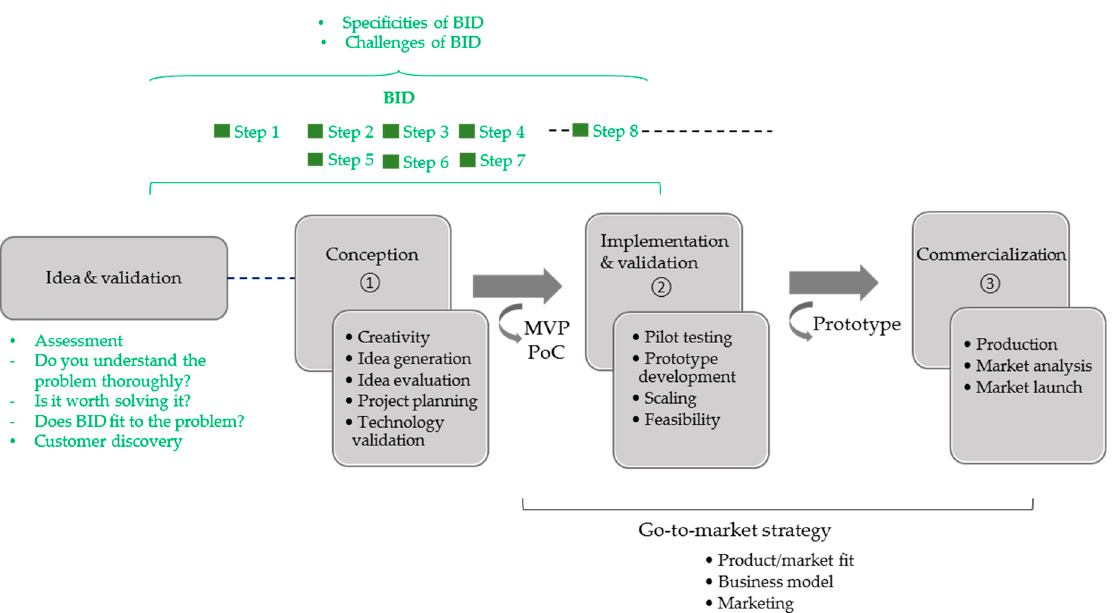
Figure 1. Phases of the innovation process linked to the eight steps of the biologically inspired design (BID) process as described with the unified problem-driven approach of biomimetics by Fayemi et al. [11]. ① , ② , and ③ indicate the main phases of a simplified innovation process. The eight steps of BID include specific tasks which must be performed and are linked to commonly known challenges [24,30–32] which must be overcome. BID: Biologically inspired design; MVP: Minimum viable product; PoC: Proof of Concept.